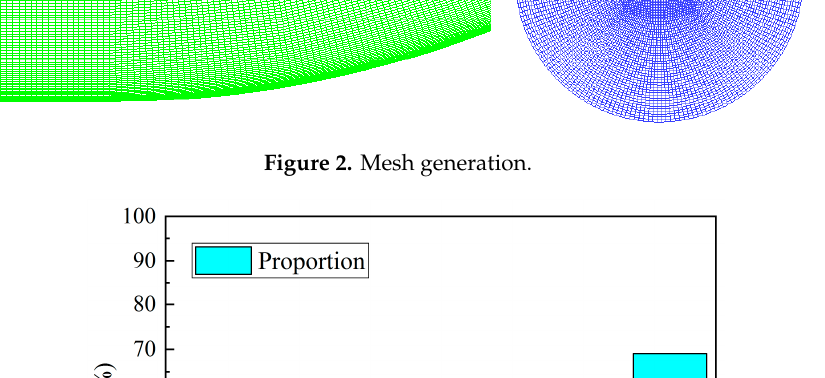
Figure 2. Mesh generation.